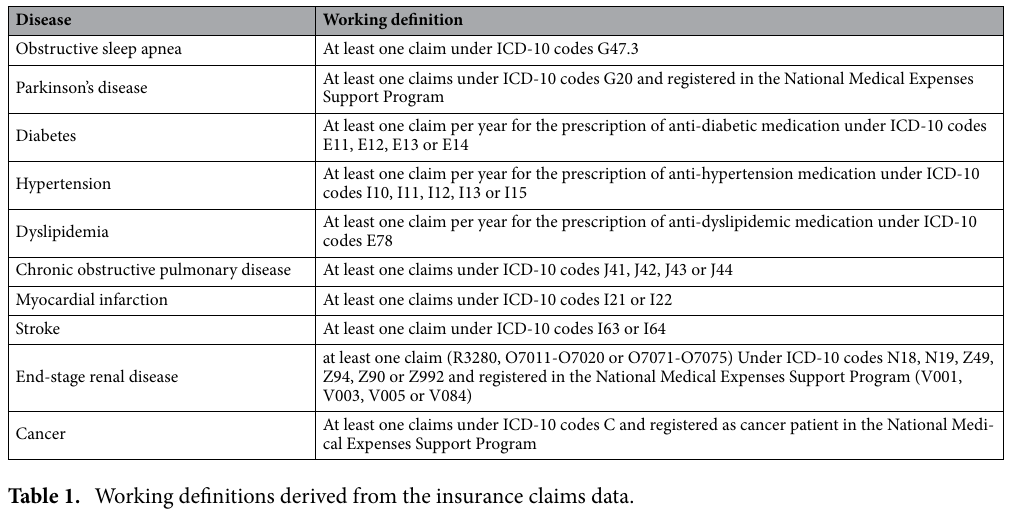
Table 1. Working definitions derived from the insurance claims